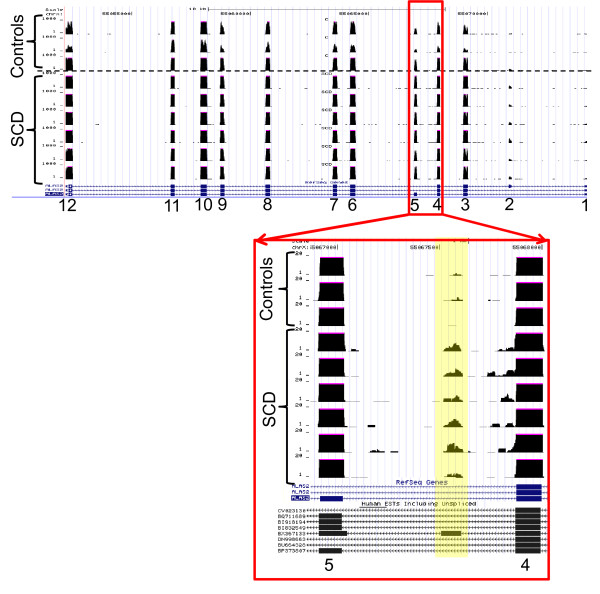
Coverage Plot of RNA-seq data forALAS2 gene RNA-seq reads forALAS2 gene are shown in genomic context (chrX:55,051,744-55,074,222). An apparently novel exon dubbed 4a, between exons 4 and 5 is expressed significantly more in SCD compared with controls (p = 0.0003). This exon has been previously observed as human EST BX367133, in a clone derived from T cells. The inset shows the region bounded by exons 4 and 5 with the coverage range expanded and truncated to 20 for each track.